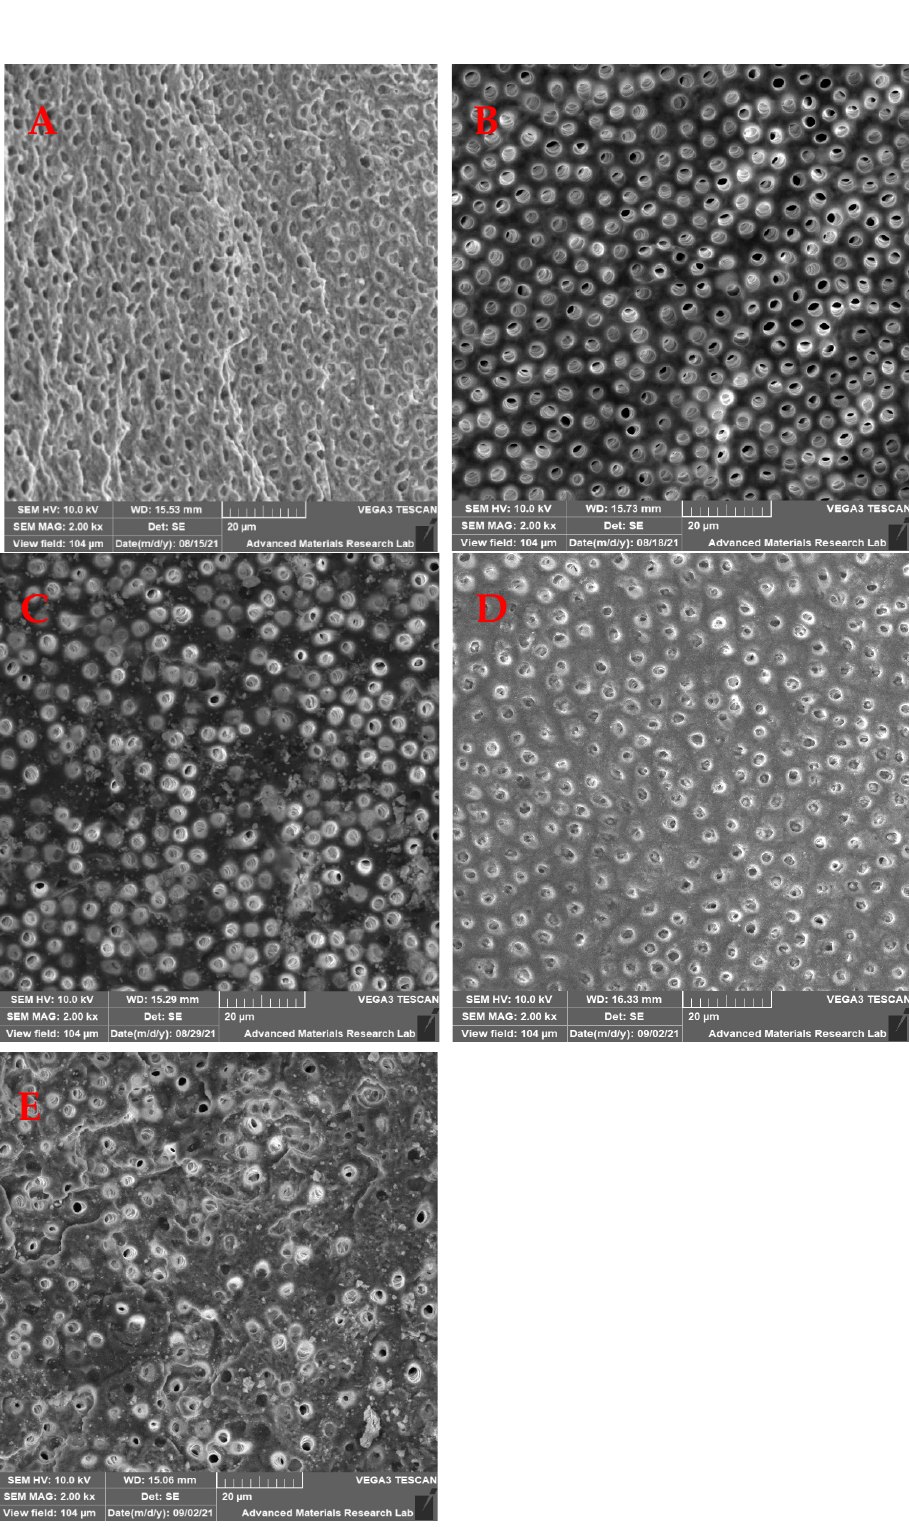
Figure 3. SEM photomicrograph (2000 × ) showing the exposed dentinal tubules at the apical third. ( A ) Ultrasonic group, ( B ) Laser 1 group, ( C ) Laser 2 group, and ( D ) Laser 3 group, ( E ) Laser 4 group.